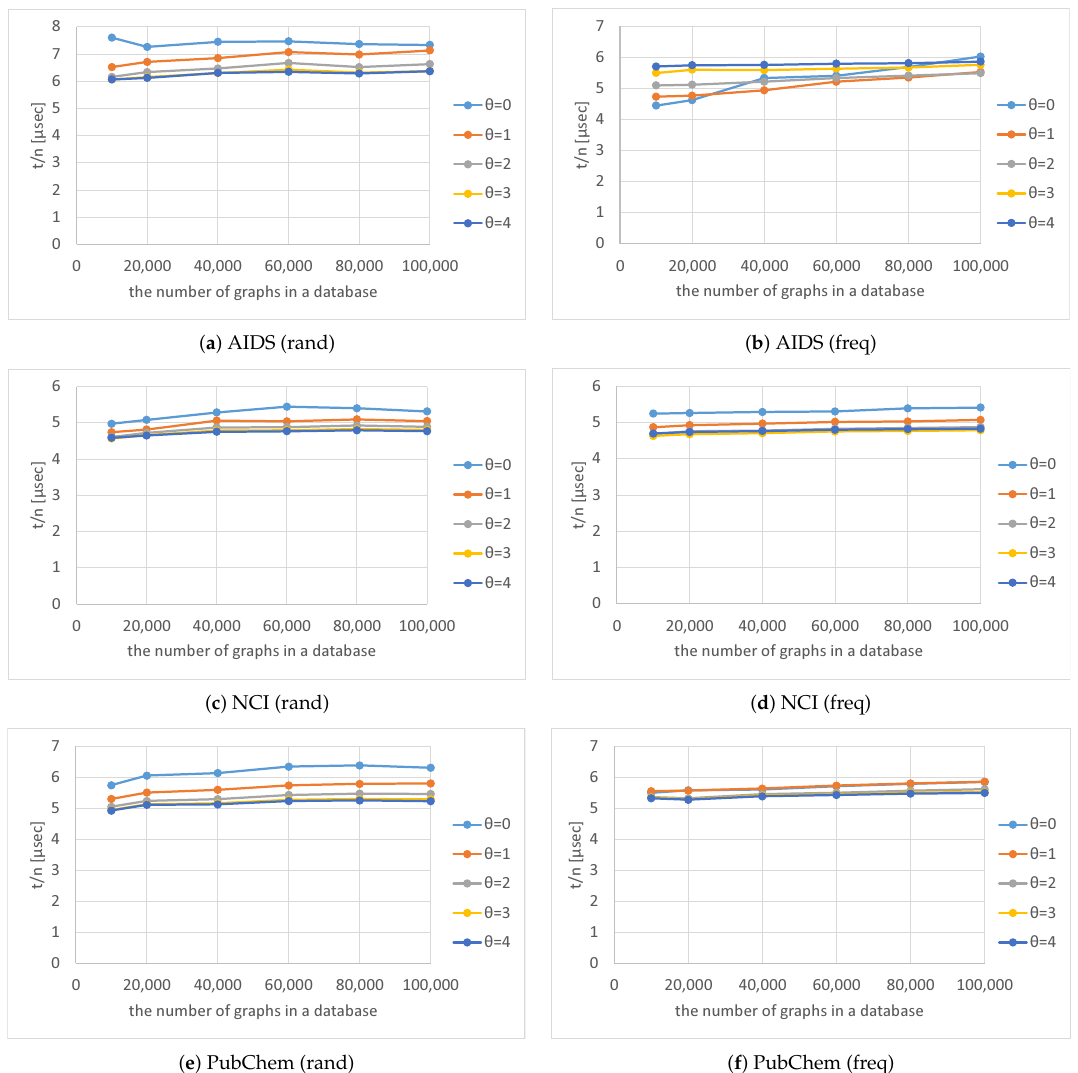
Figure 11. Computation time per node t / n for various numbers of graphs | G | in a database and various thresholds θ .